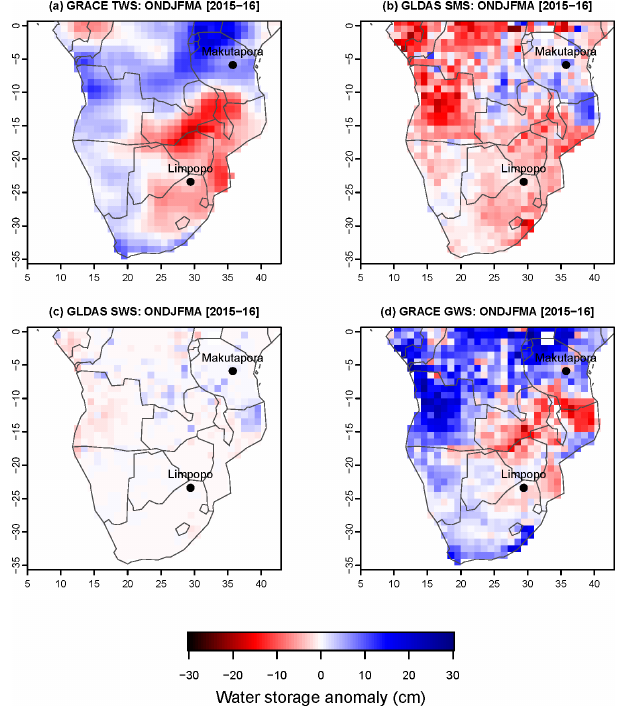
Figure 4. Water storage anomaly components (cm) over the study domain for the wet season (October–April) of 2015–2016 minus long-term annual mean from 2003–2015. (a) GRACE ensemble- mean total water storage anomaly ( (cid:49) TWS; from CSR, JPL Mas- cons and GRGS GRACE products). (b) GLDAS ensemble-mean soil moisture storage anomaly ( (cid:49) SMS; four land surface mod- els: CLM, NOAH, VIC and MOSAIC). (c) GLDAS ensemble- mean surface runoff or surface water storage anomaly ( (cid:49) SWS; from four land surface models: CLM, NOAH, VIC and MO- SAIC), and (d) GRACE–GLDAS-derived ensemble-mean ground- water storage anomaly ( (cid:49) GWS; from three estimates of (cid:49) GWS from three GRACE